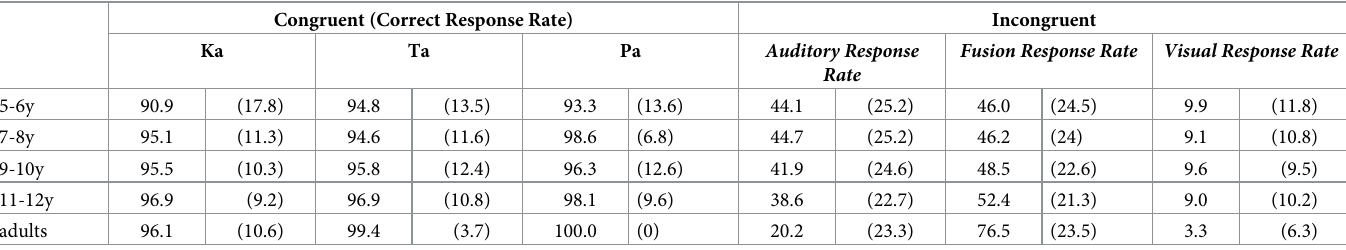
Table 2. Average performances in the phoneme perception task (%).